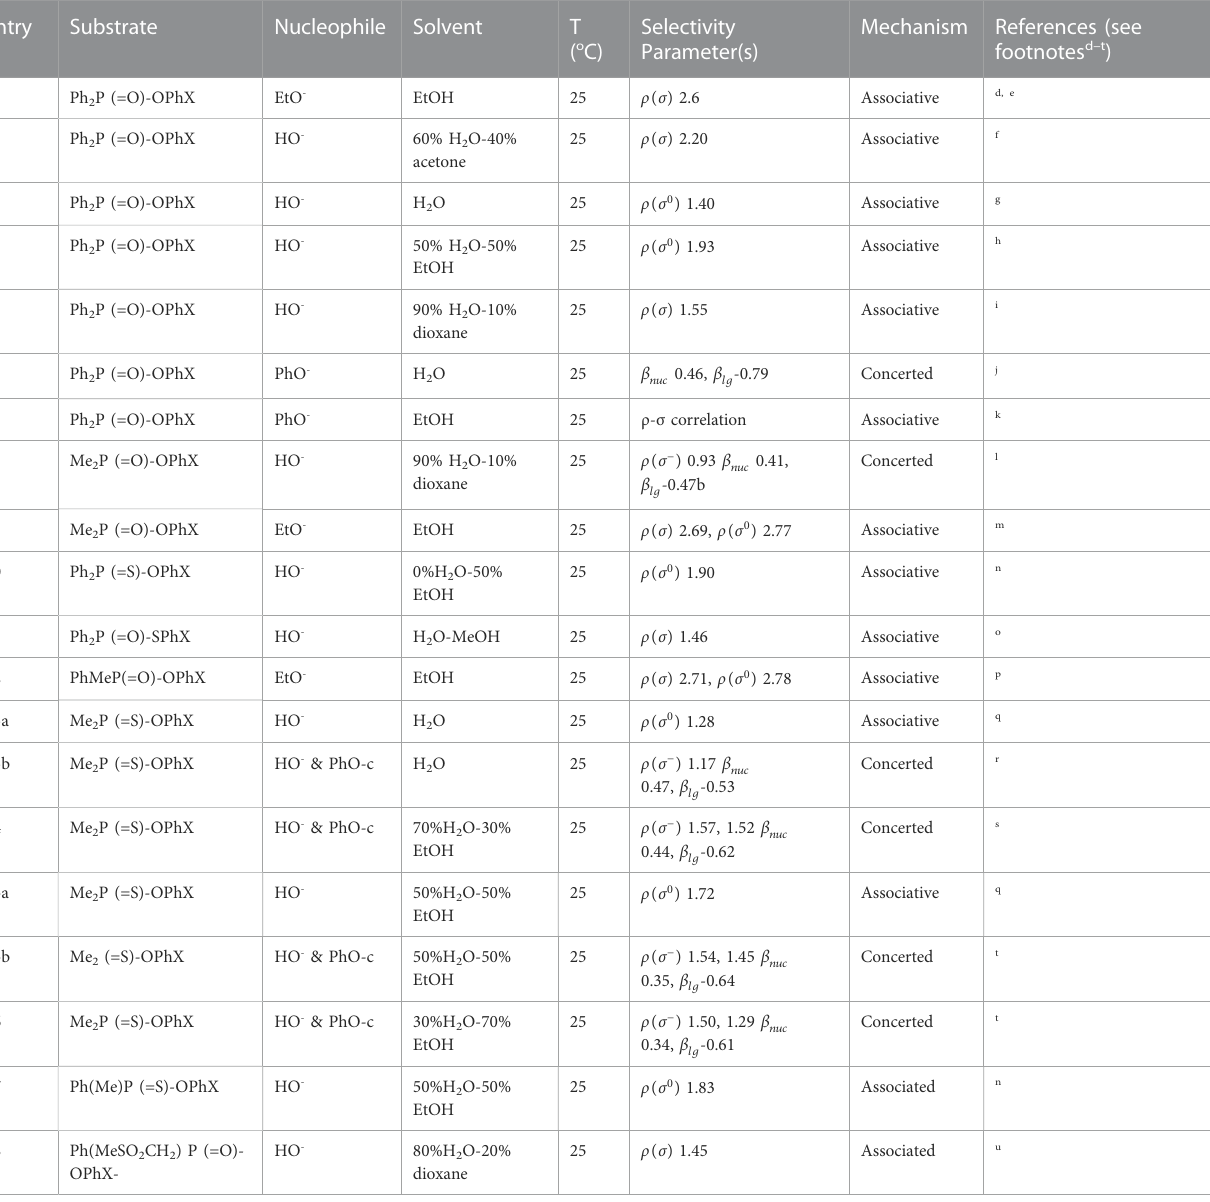
TABLE 2Hammettand/or Brönsted selectivity parameters for the reactionsof phosphinate andphosphinothioate esterswith oxyanionicnucleophilesindifferent solvents a